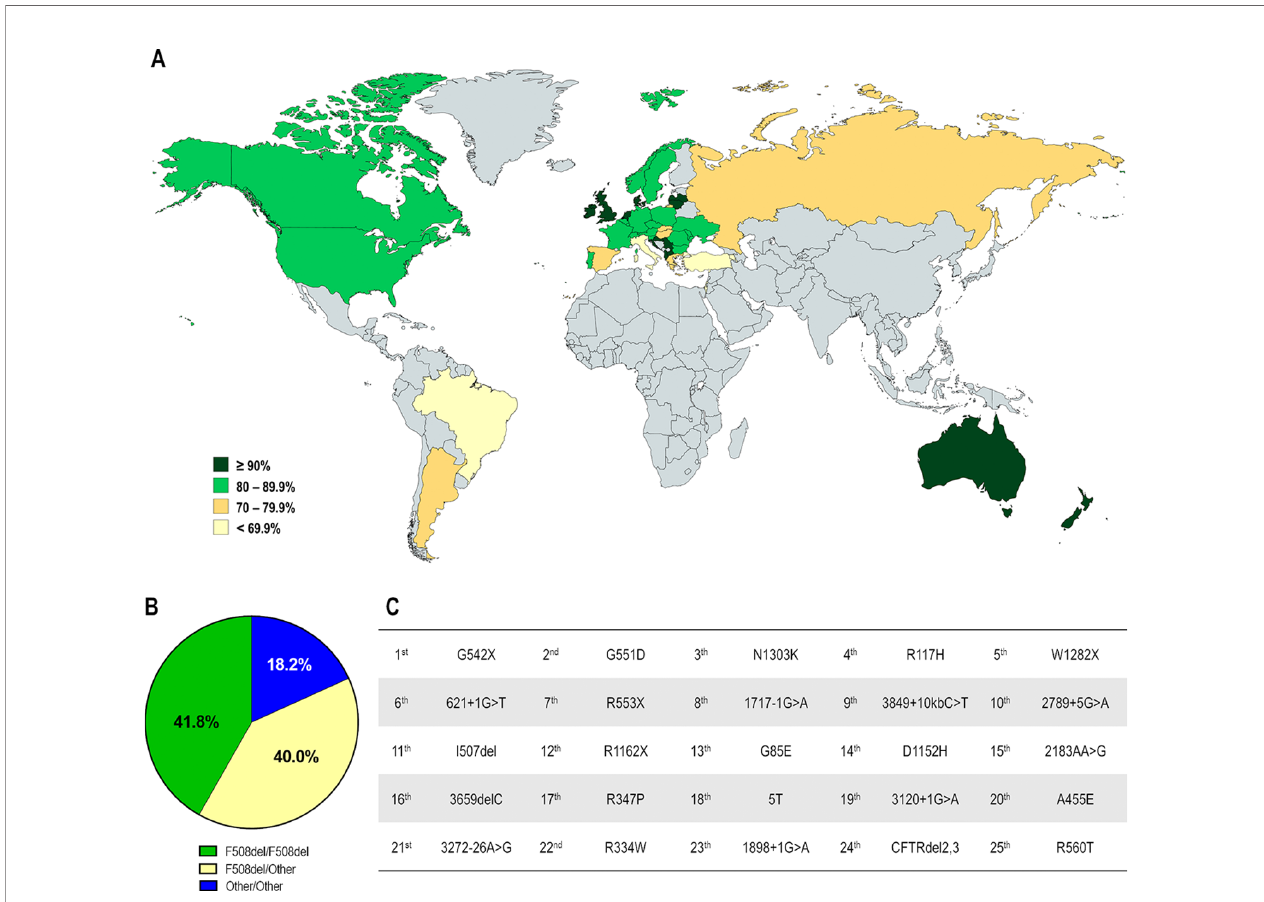
FIGURE 3 | Demography of CF transmembrane conductance regulator (CFTR) mutations in different countries. (A) Distribution according to the percentage of patients carrying the F508del mutation in at least one allele. (B) Global distribution by CF genotype: F508del-homozygous, F508del-heterozygous and carrying non- F508del mutations in both alleles. (C) Top 25 most prevalent non-F508del CFTR mutations considering the whole CF population. [Data compiled from the last Patient Registry Report in Argentina (Pereyro et al., 2018), Australia (Cystic Fibrosis Australia, 2018), Brazil (Brazilian Cystic Fibrosis Study Group, 2019), Canada (Cystic Fibrosis Canada, 2019), Europe (European Cystic Fibrosis Society, 2019), New Zealand (Cystic Fibrosis New Zealand, 2019), UK (Cystic Fibrosis Trust, 2019), and the USA (Cystic Fibrosis Foundation, 2019), and CFTR2